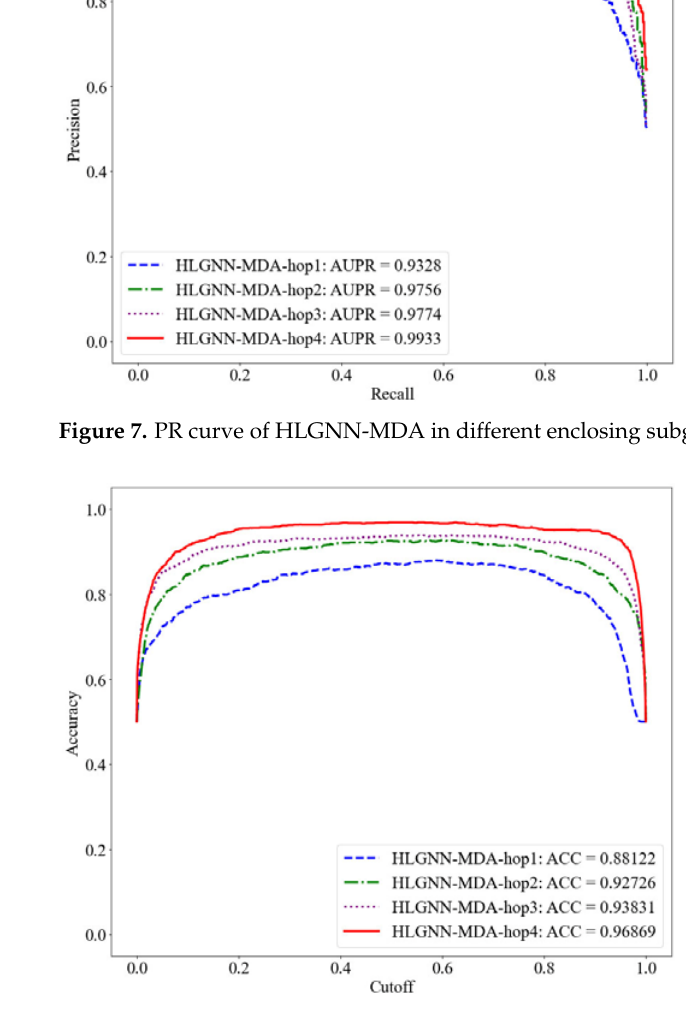
Figure 8. Accuracy curve of HLGNN-MDA using different enclosing subgraph hops.